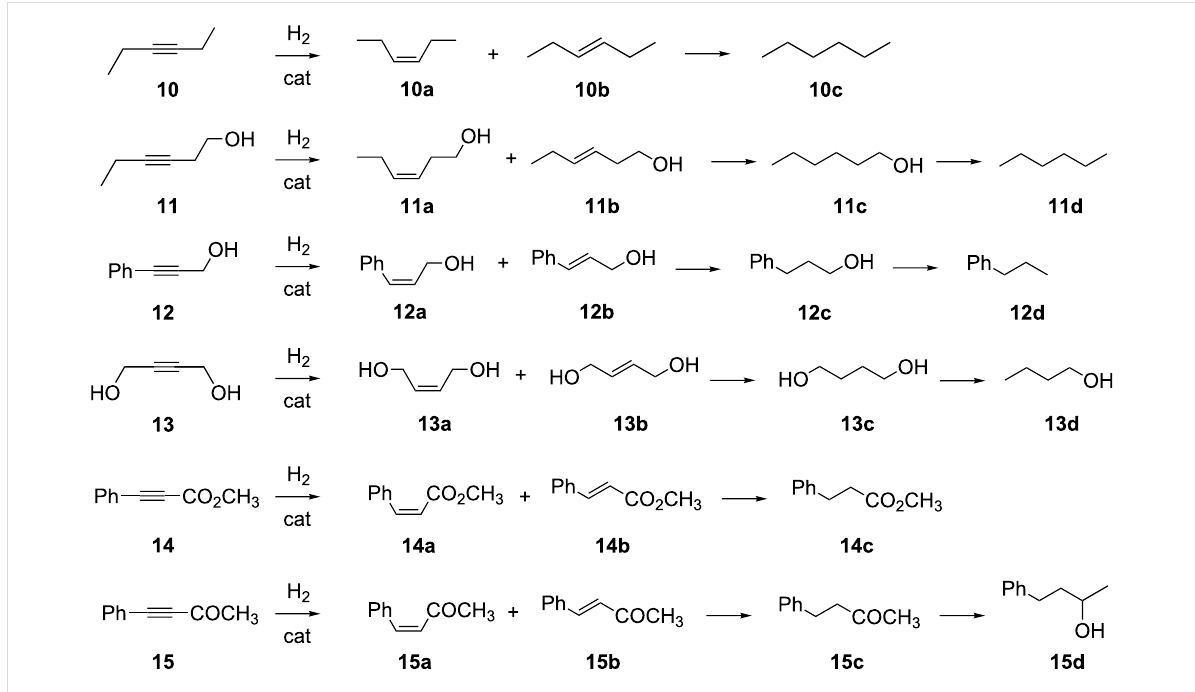
Scheme 3: Hydrogenation reactions of internal alkynes with potential products and labelling